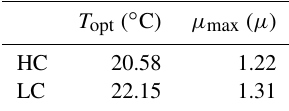
Table 2. The optimal temperature for growth ( T opt ) and the maxi- mum growth rate ( µ max ) at T opt for E. huxleyi grown in 400µatm (LC) and 1000µatm (HC) CO 2 concentrations. T opt and µ max as estimated from the fitted curves in Fig. 1 by numerical optimiza-